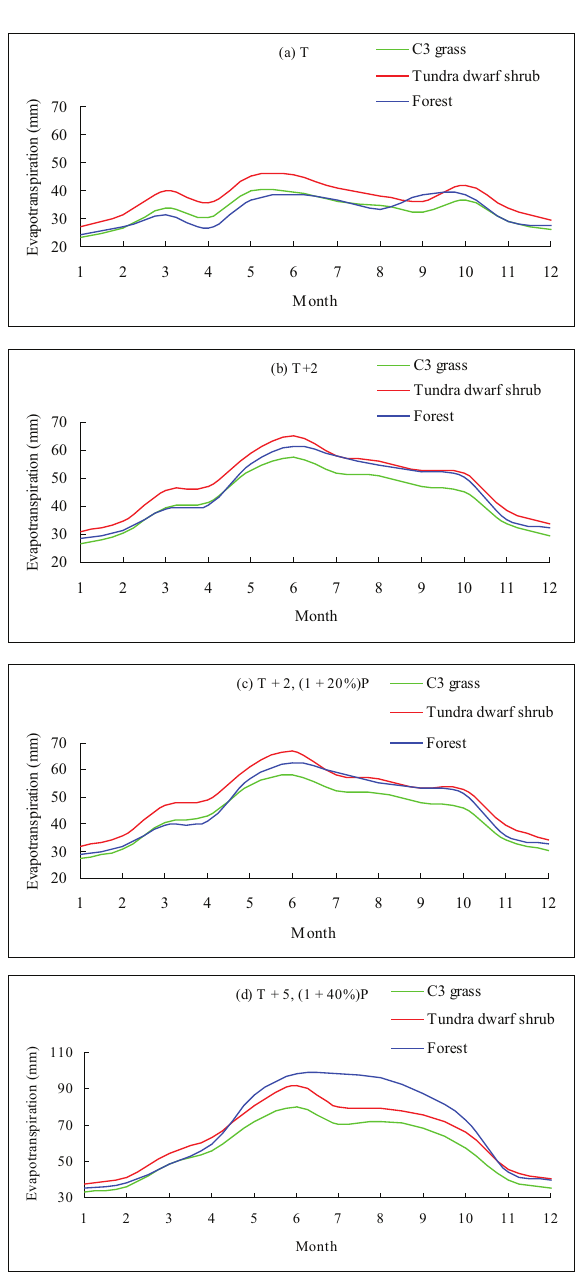
Figure 8. Mean monthly LAI averaged